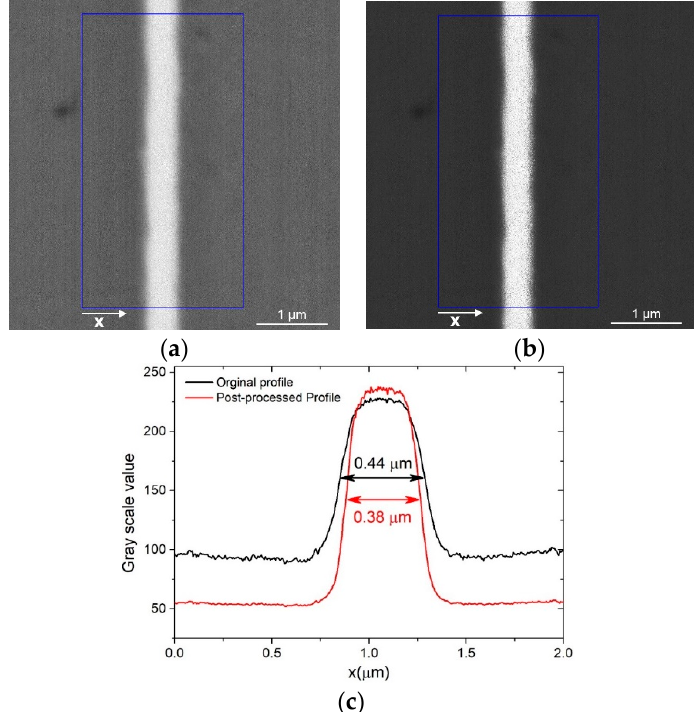
Figure 9. ( a ) Au film between two Cu layers, the image shown as acquired from the instrument; ( b ) the same image as ( a ) but post-processed to enhance the separation between the layers; ( c ) plot profile of the images ( a , b ) and the extrapolated thickness of the Au